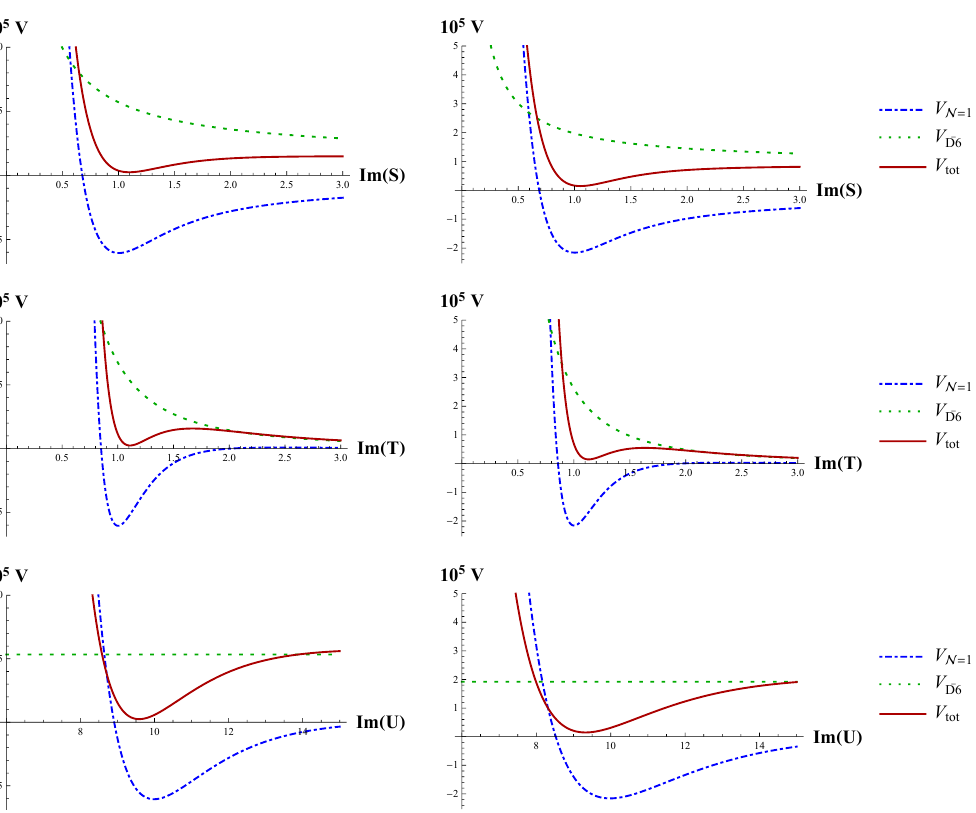
Figure 1 . 2D plots of the total scalar potential V tot , the anti-de Sitter potential V N =1 and the D 6 potential V . The left column of plots corresponds to Set 1 while the right is Set 2. Starting from D 6 the top we have the Im( S ) direction, followed by Im( T ) and Im( U ). In all plots we see clearly the anti-de Sitter and de Sitter vacua as well as the uplift term.